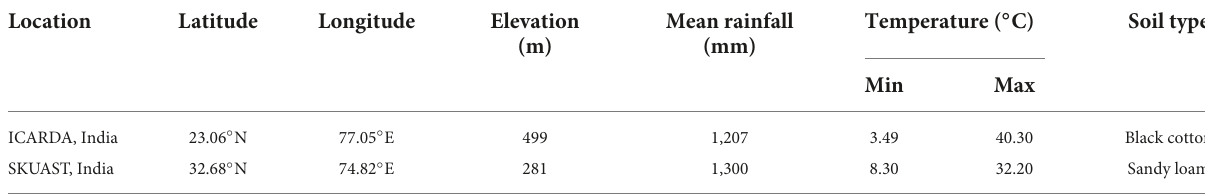
TABLE 1 Agro-climatic description of the locations where advanced lentil interspecific derivatives were evaluated during the study period. Location Latitude Longitude Elevation